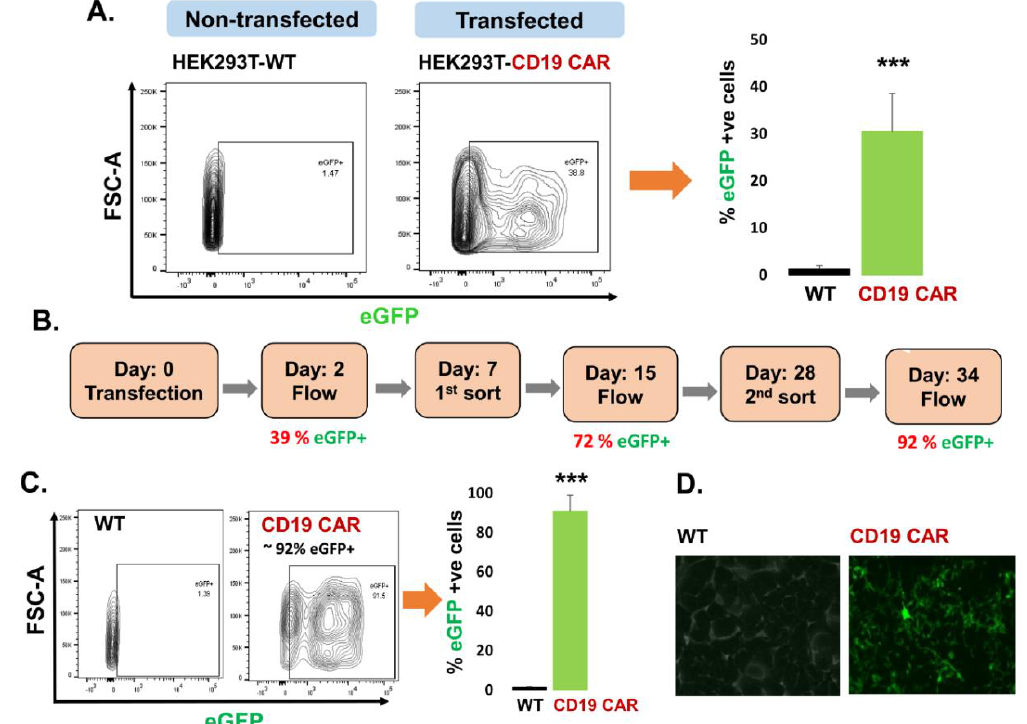
Figure 1. Transfection of the HEK293T producer cell line. ( A ) CD19 CAR plasmid transfection into the HEK293T cells based on eGFP expression (39%) compared to control non-transfected (WT) HEK293T cells by flow cytometry, ( n = 3 independent experiments). ( B ) Timeline for enrichment of HEK292T cells transfected with CD19 CAR plasmid demonstrate stable transfection in enriched cells for more than a month. ( C ) Contour plot of flow cytometry confirming around 92% eGFP positive cells after 2nd round of cell sorting CD19 CAR positive HEK293T cells compared to non-transfected (WT) HEK293T cells, ( n = 3 replicates). ( D ) Fluorescence microscopy demonstrating expression of eGFP in CD19 CAR transfected HEK293T cells. p -value (*** p < 0.001).